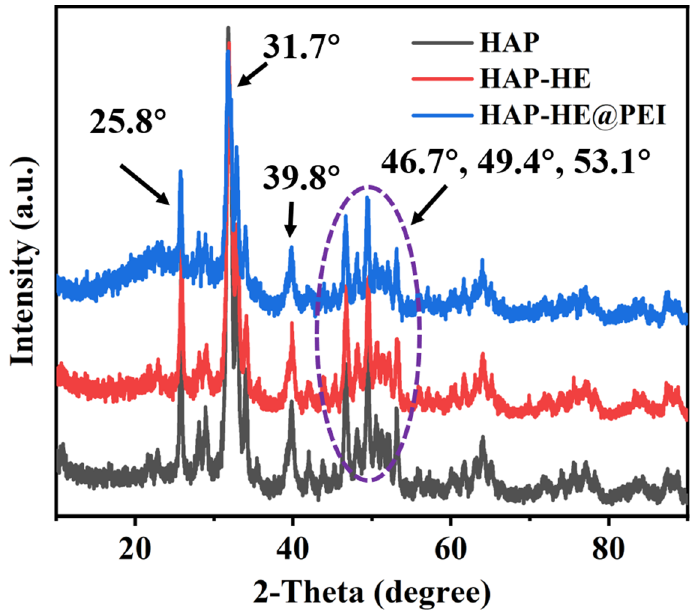
Figure 2. XRD patterns of HAP, HAP − HE and HAP − HE@PEI.